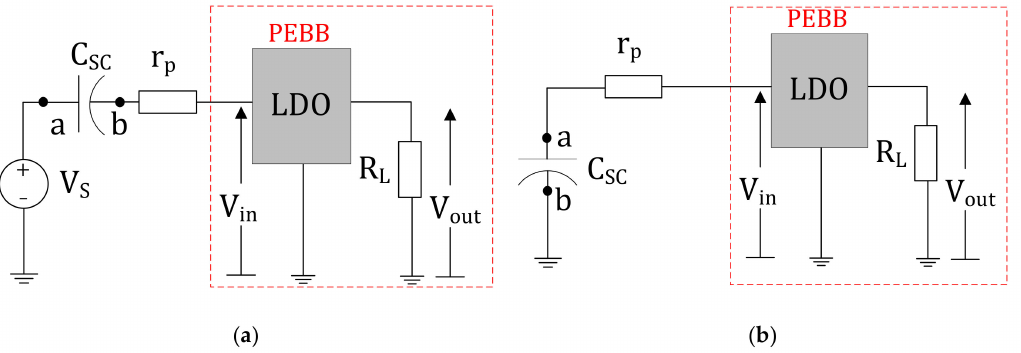
Figure 6. The SCALoM concept in the SCALDO technique: ( a ) LDO acting as the PEBB in Figure 4a where the input resistance of the LDO (the equivalent of R L in Figure 4a) is much higher compared to the parasitic loop resistance r p , ( b ) energy accumulated in the supercapacitor feeding the LDO to keep the charge balance